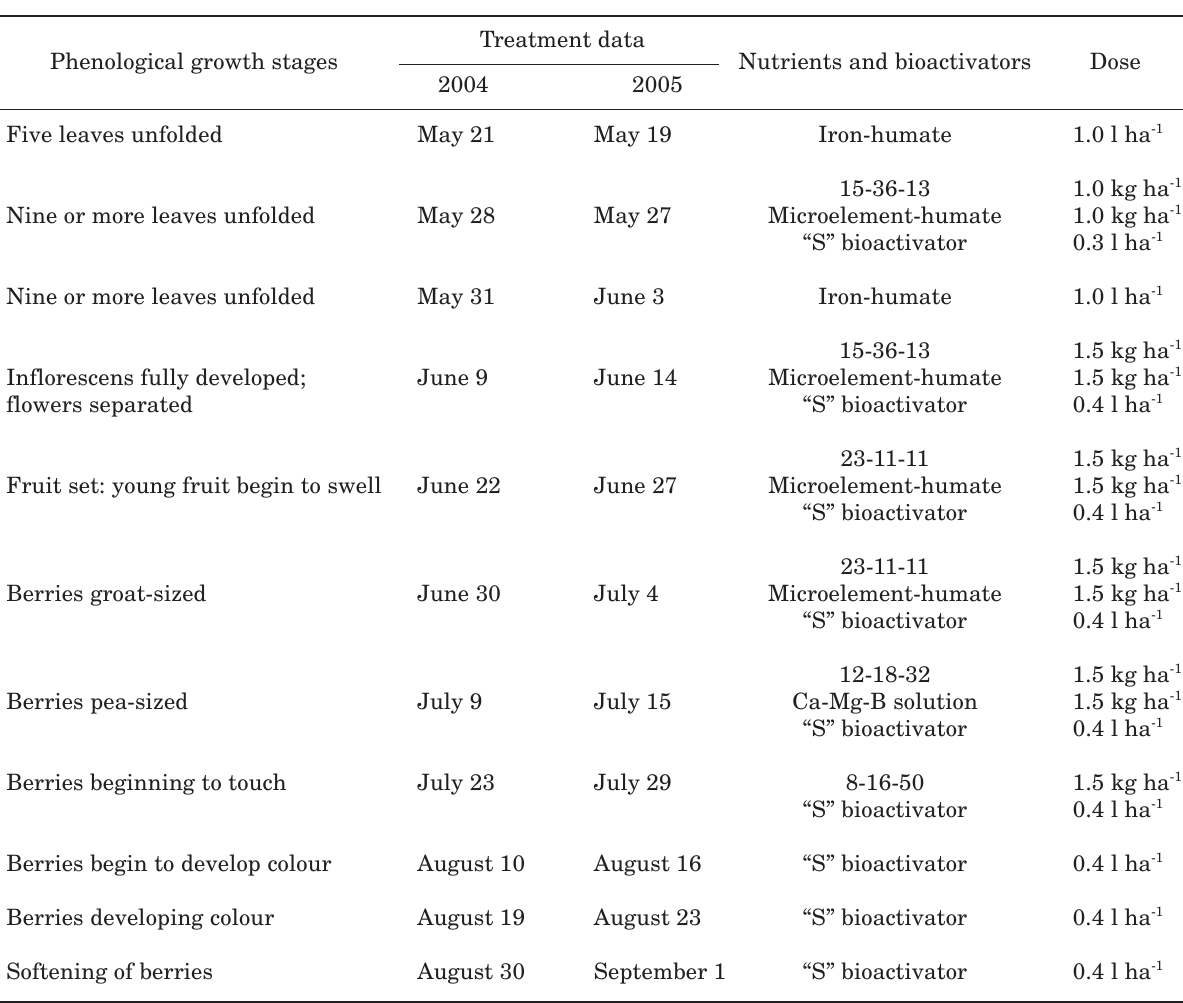
Table 3 - Details of foliar treatment application. Treatment data Phenological growth stages Nutrients and